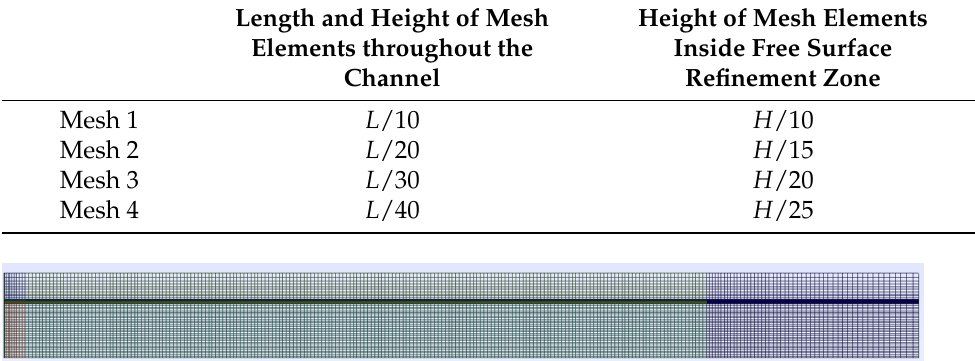
Table 1. Length and height of mesh elements used in the mesh independence study.